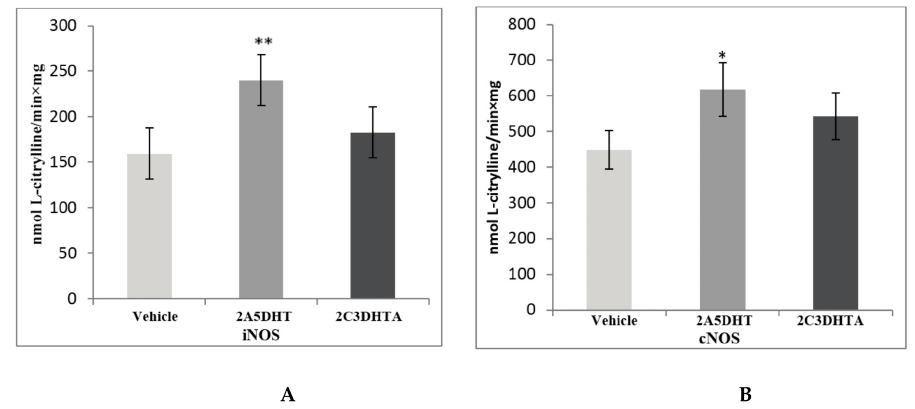
Figure 2. Activity of nitric oxide synthases (iNOS—( A ) and cNOS—( B )) in homogenates of small intestinal mucosa of rats of the following groups: group 1—control group (vehicle), group 2—action of a dual COX/LOX inhibitor—2A5DHT, group 3—action of H 2 S releasing dual COX/LOX inhibitor—2C3DHTA. Mean ± SD, n = 8 in each group of animals. * p ≤ 0.05, ** p ≤ 0.01, in relation to control animals.